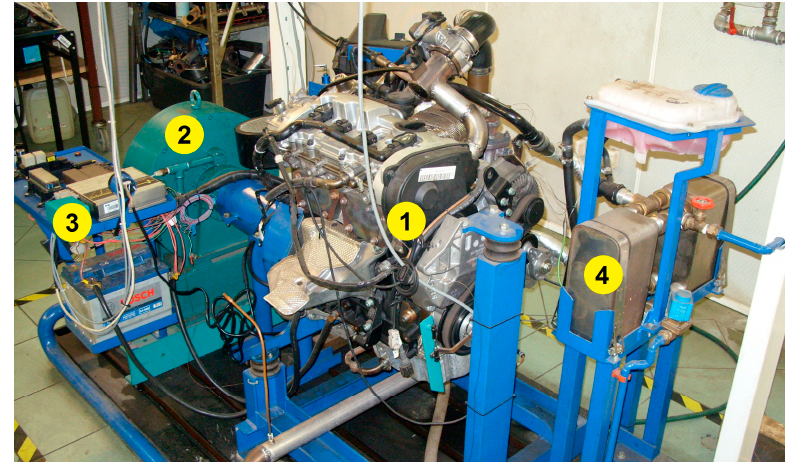
Figure 5. General view of the test stand of the engine with the additional expansion of exhaust gases; 1—Tested engine, 2—Eddy-current brake dynamometer, 3—Engine management system, 4—Engine